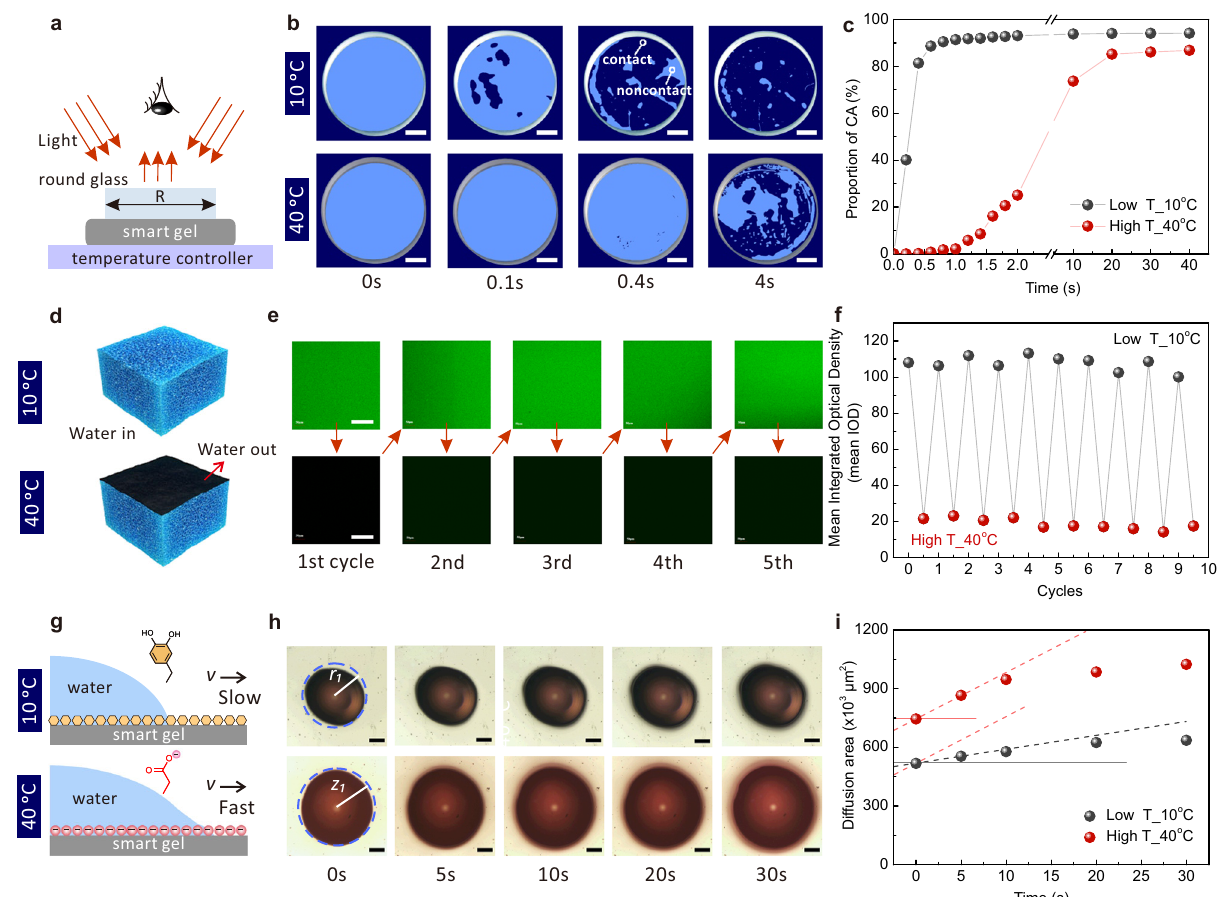
Fig. 2 | Dynamic multiscale contact mechanism of DMCS-hydrogel. a A sche- matic diagram to observe the contact evolution between DMCS-hydrogel and quartz glass. b Snapshots of the contact images of the low- and high-temperature DMCS-hydrogel.Thebrightregionwasincontactwiththeglassandthedarkregion was not in contact. Scale bar, 5mm. c The relationship between the contact time and the percentage of effective contact area. d Surface wetting and dewetting of DMCS-hydrogel were observed by a confocal microscope. e The fl uorescent